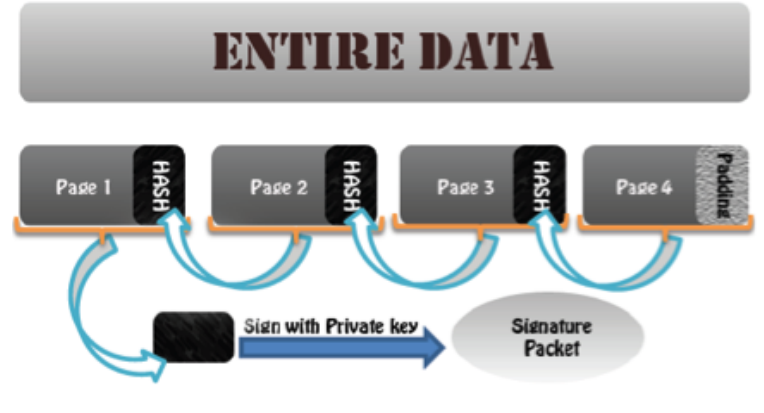
Figure 4. The hash dependency structure in Seluge (adapted from